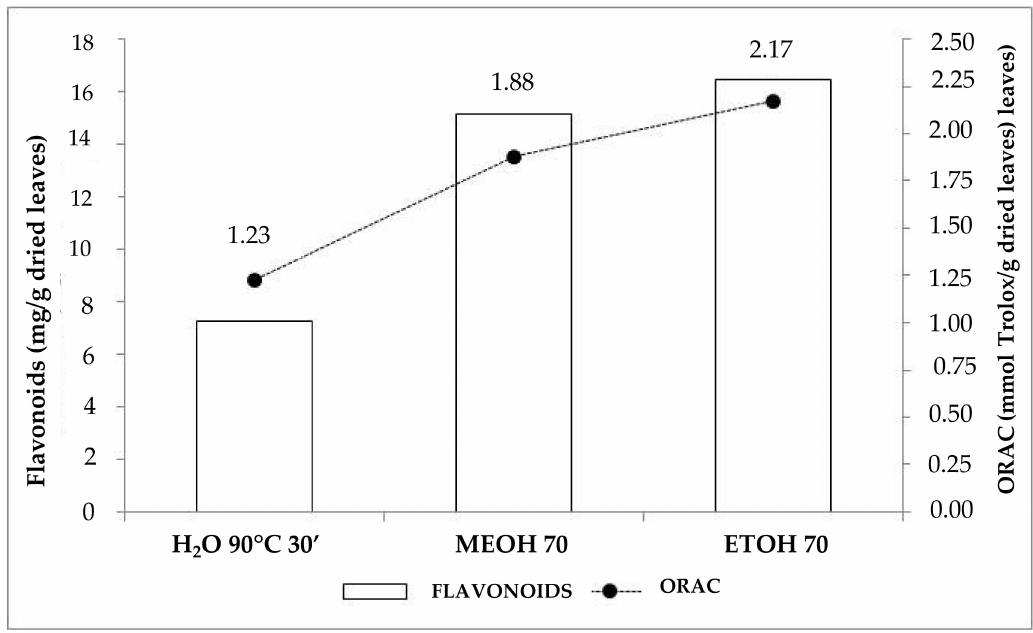
Figure 2. Relationship between the ORAC values and the flavonoid content of the different